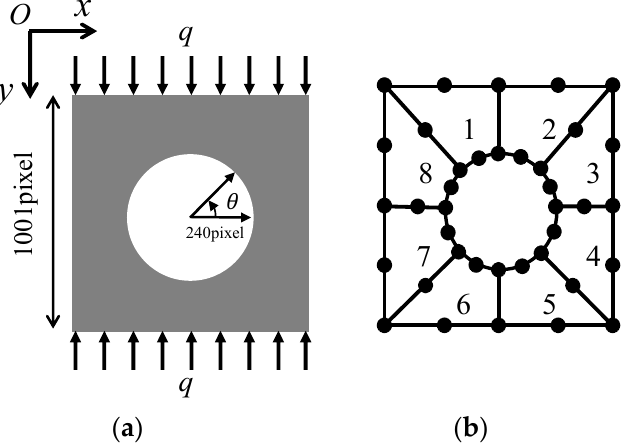
Figure 6. The g eometry of open-hole specimen ( a ) and meshing scheme in Q8-DIC ( b ). Figure 6. The geometry of open-hole specimen ( a ) and meshing scheme in Q8-DIC ( b